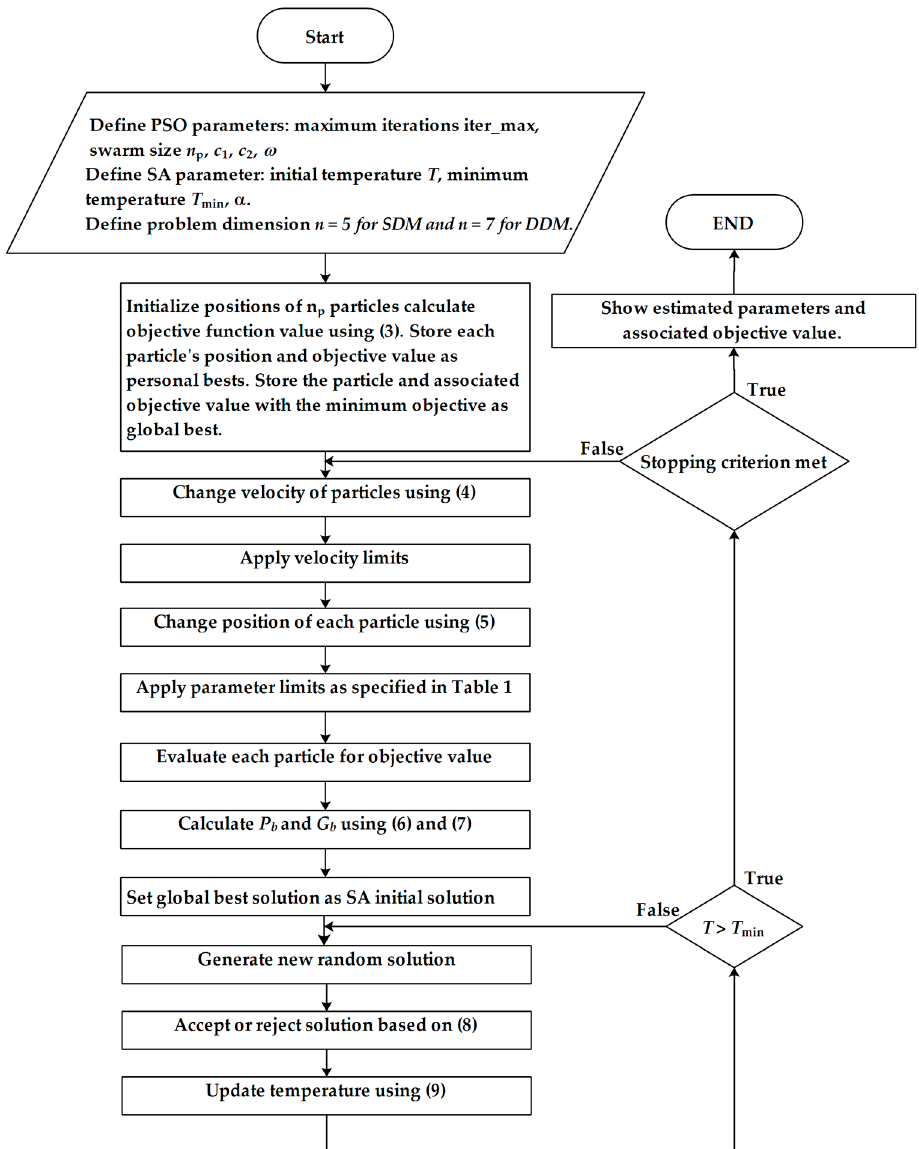
Figure 3. Flowchart of the HPSOSA.